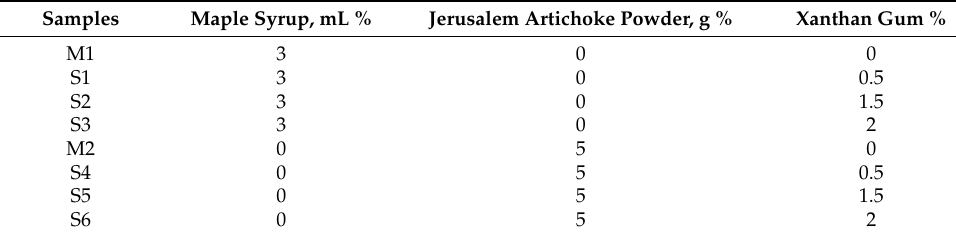
Table 1. The content of components used in walnut butter mix.